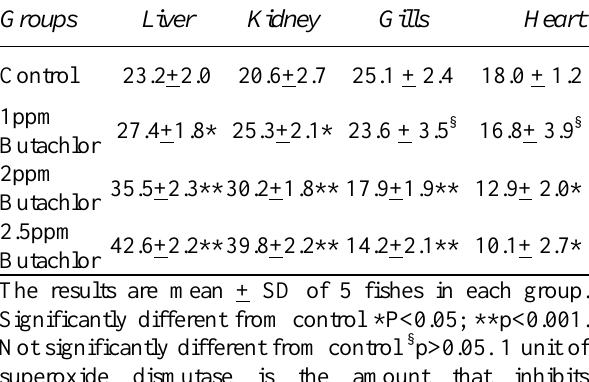
The results are mean + SD of 5 fishes in each group.